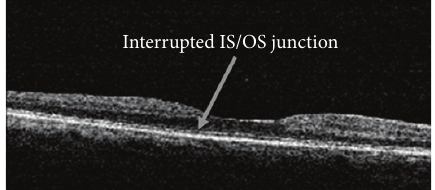
Figure 2: IS/OS interrupted in a patient from the Chloroquine